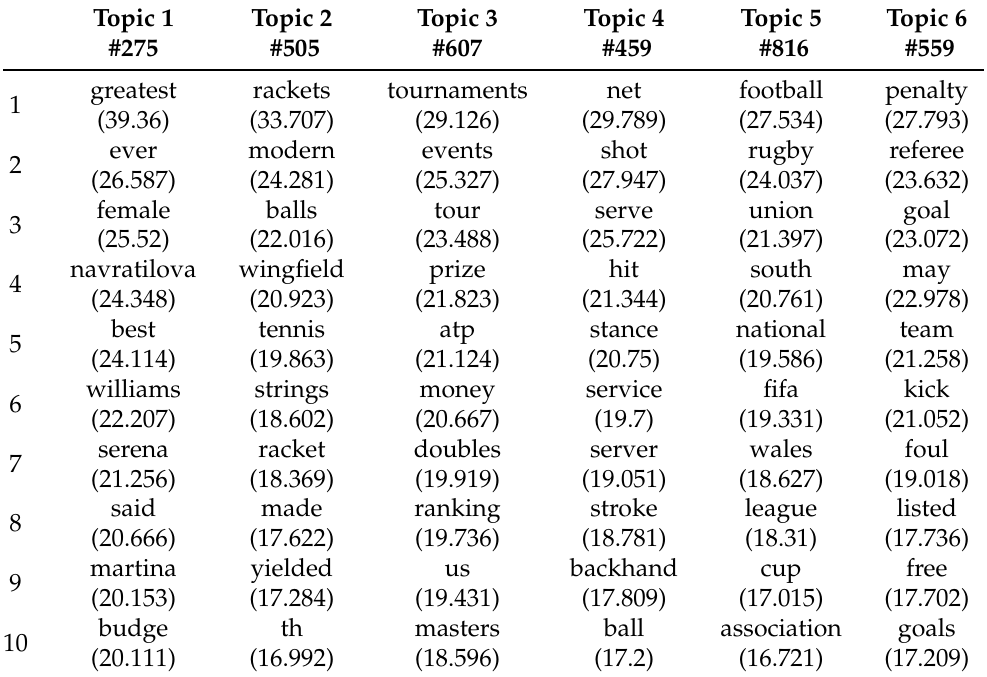
Table A10. Each column lists the top 10 representative words per dimension of the basis matrix A (cid:48)